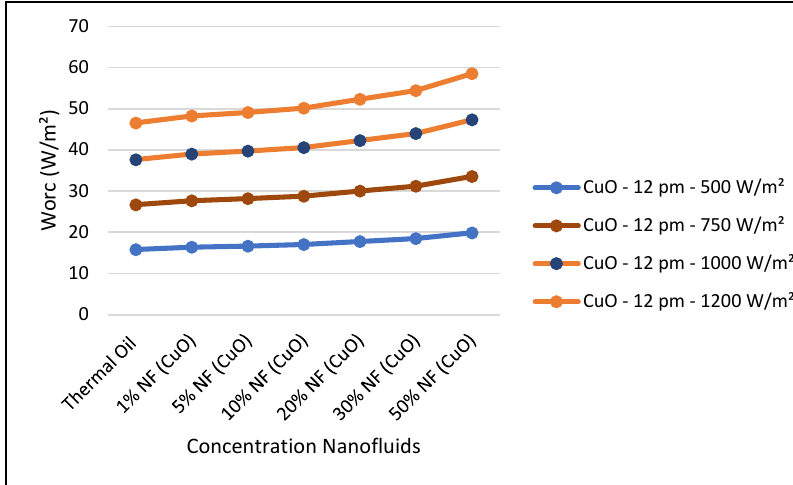
ff erent concentrations. Appl. Syst. Innov. 2019 , 2 , x FOR PEER REVIEW